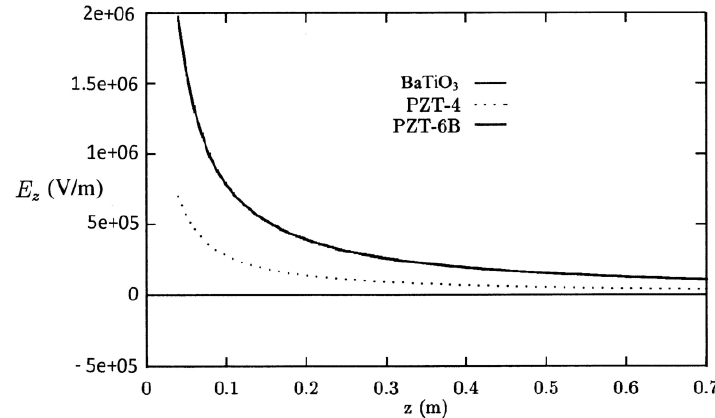
Figure 6. Electric Field in different magneto-piezoelastic solids due to a line electric charge of intensity 1.0 1 Cm  applied to the